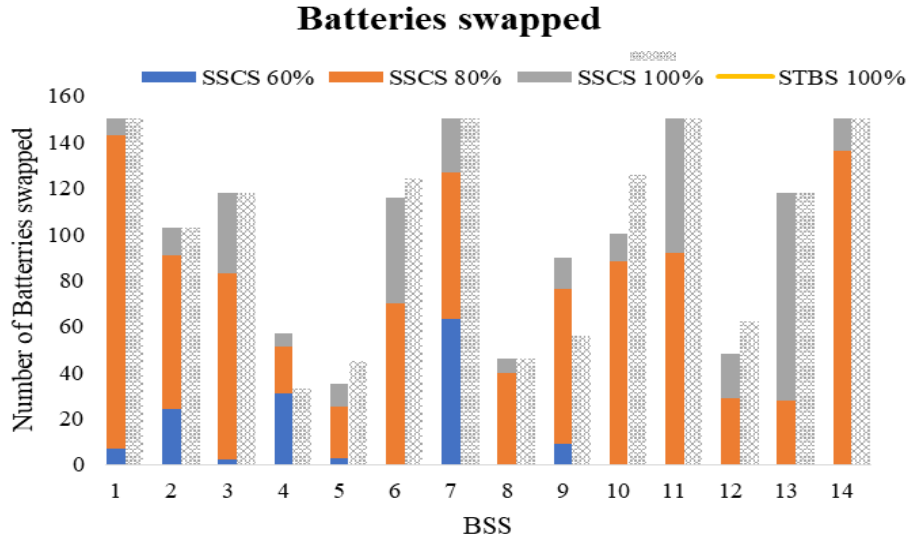
Figure 7. Comparison of the number of swapped batteries. Table 6. Results comparison with the alternative